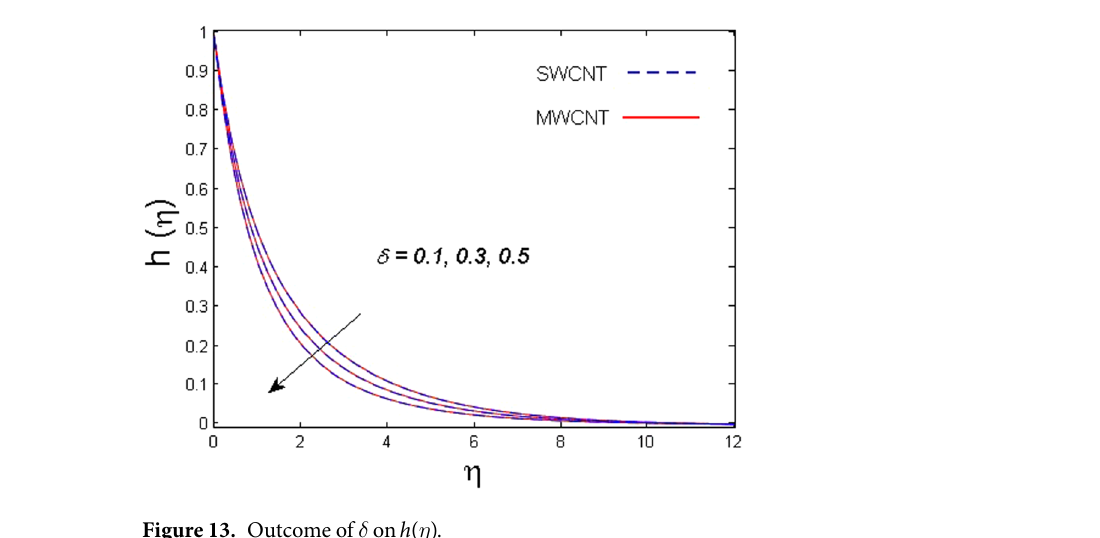
Figure 13. Outcome of δ on η h ( ) .